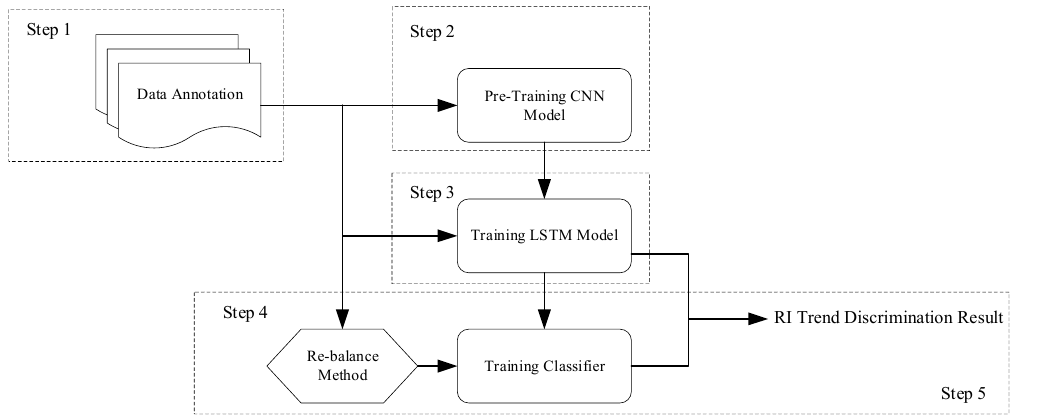
Figure 3. Model diagram.